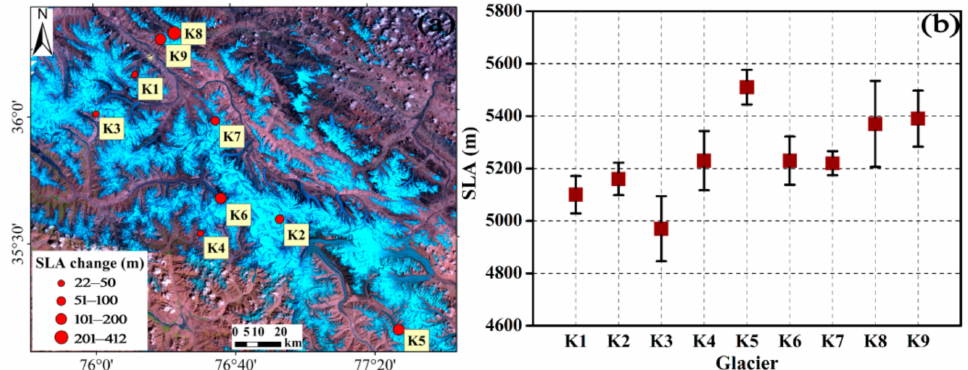
Figure 8. ( a ) SLA changes and ( b ) mean SLA of the nine analyzed glaciers across the Karakoram Mountains during the 1989–2019 period. The error bars in ( b ) represent one standard deviation from the mean.